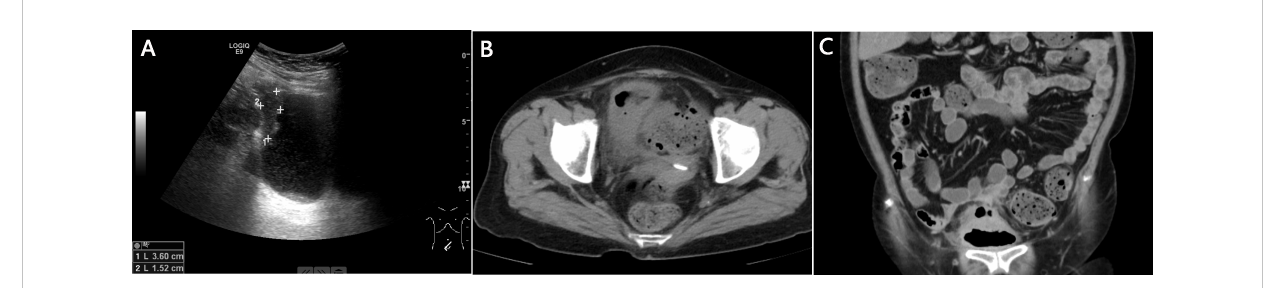
FIGURE 1 Imaging examinations. (A) : Ultrasound examination. The right bladder wall was thickened, and a 3.6 cm × 1.5 cm lesion was revealed; (B) : Abdominopelvic computed tomography (CT). Focal thickening of the bladder wall and gas in the bladder were noted; (C) : Computed tomography urography (CTU). Gas between the bladder dome and adjacent sigmoid colon, and a thickened bladder and sigmoid colon wall were